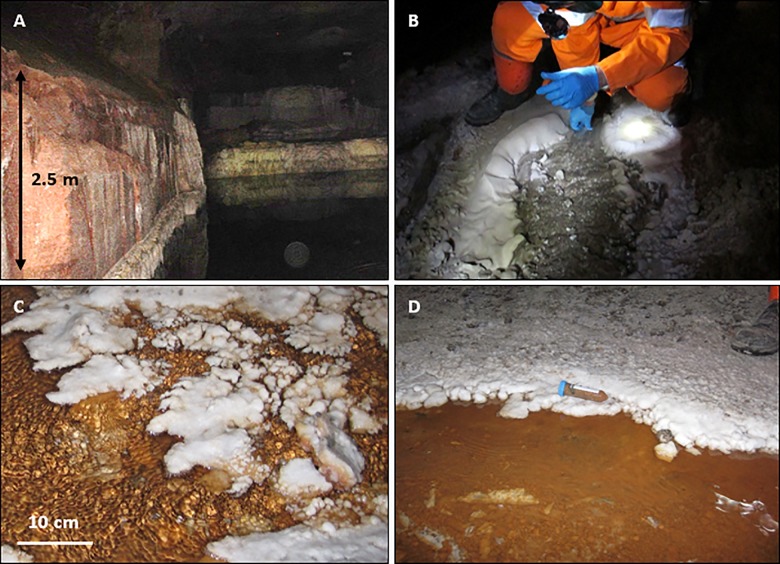
Contextual photographs of two brine pools sampled during this study. (A) Billingham Baths brine pool. (B) Brines flowing into brine pool at Billingham Baths (person for scale). (C) Close up of brine flows at 215. (D) Brine flow at 215. Red color is from the clay minerals present. Fifty microliter falcon tube for scale.